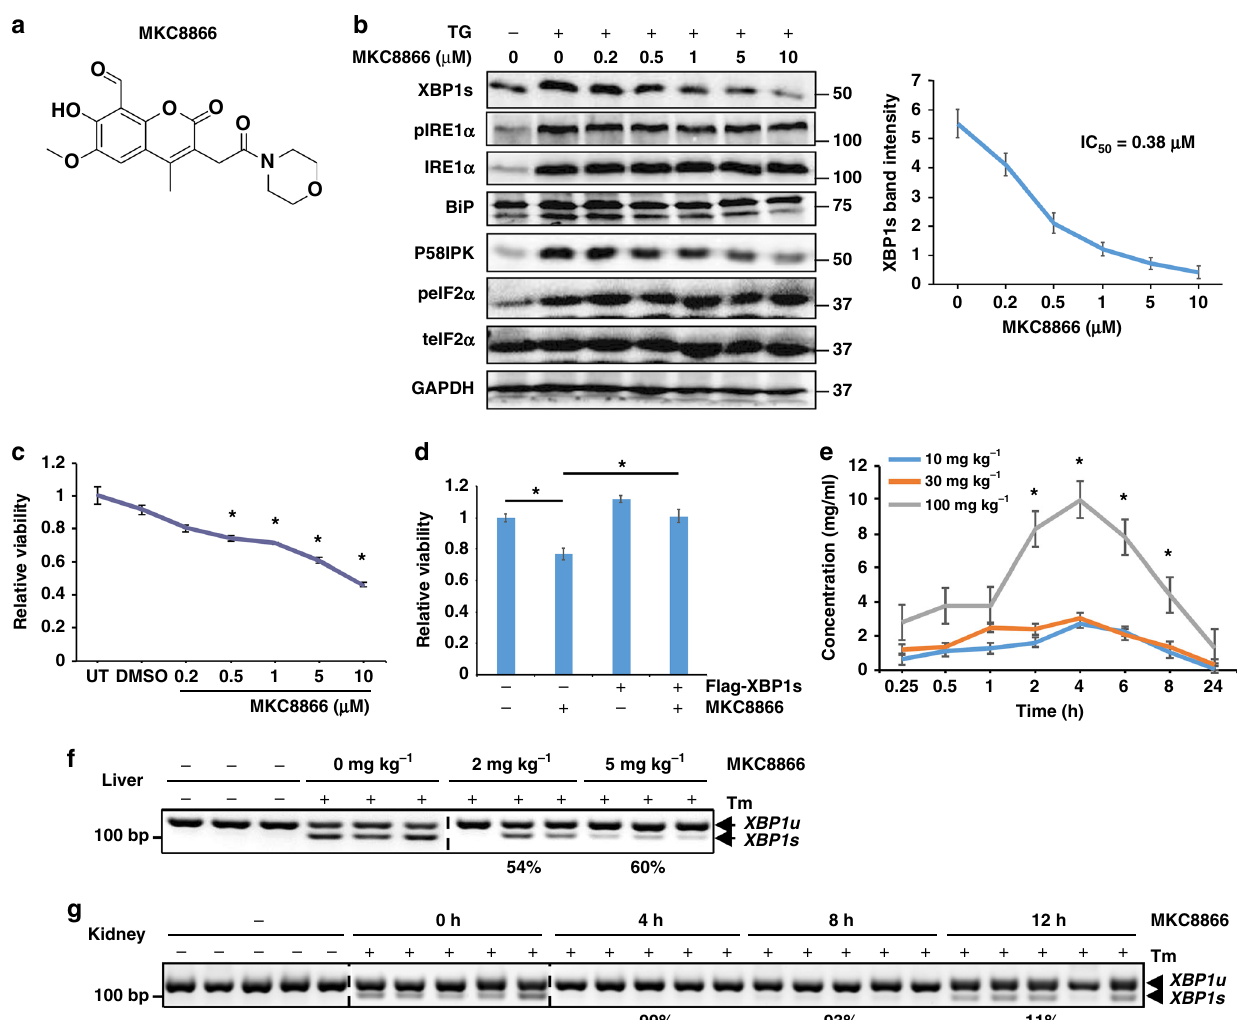
Fig. 1 Functional characterization of MKC8866 on IRE1 α RNase activity. a Chemical structure of MKC8866. b LNCaP cells were cultured in regular growth medium and treated with 30 nM TG and the indicated doses of MKC8866 for 24 h. Protein expression was determined by Western analysis. XBP1s Western blot intensity was quanti fi ed and normalized to GAPDH from three different experiments, and used to calculate the IC 50 . c LNCaP cells were either left untreated (UT), or treated with vehicle (DMSO) or MKC8866 with indicated doses. Cell viability was measured after 3 days. d LNCaP cells were transfected with either empty vector (pCDNA3) or the pCDNA3-Flag-XBP1s plasmid, and treated with vehicle (DMSO) or 10 μ M MKC8866. Cell viability was measured after 3 days. e Mice ( n = 3) were orally dosed with indicated amounts of MKC8866 and its plasma concentration was pro fi led post treatment. f Mice ( n = 3) were intraperitoneally injected with 1 mg kg − 1 tunicamycin (Tm) for 4 h and orally gavaged with the indicated dosage of MKC8866 for 2 h before harvesting its liver. Quanti fi ed average inhibition ratio is shown below the corresponding treatment. g Mice ( n = 5) were dosed with 1 mg kg − 1 tunicamycin (Tm) and 4 mg kg − 1 MKC8866 for the indicated time length before harvesting its kidney. Quanti fi ed average inhibition ratio is shown below the corresponding treatment. * P < 0.05, Student t -test, error bars denote